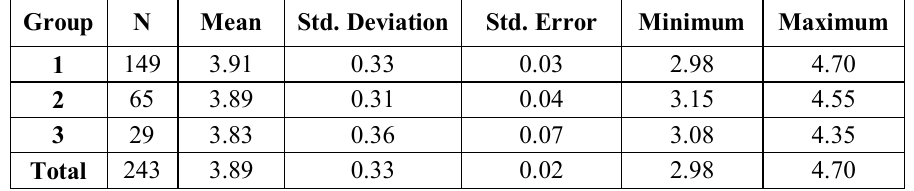
Table 1 – Mean Scores of 3 Groups in terms of TOA in Final Survey